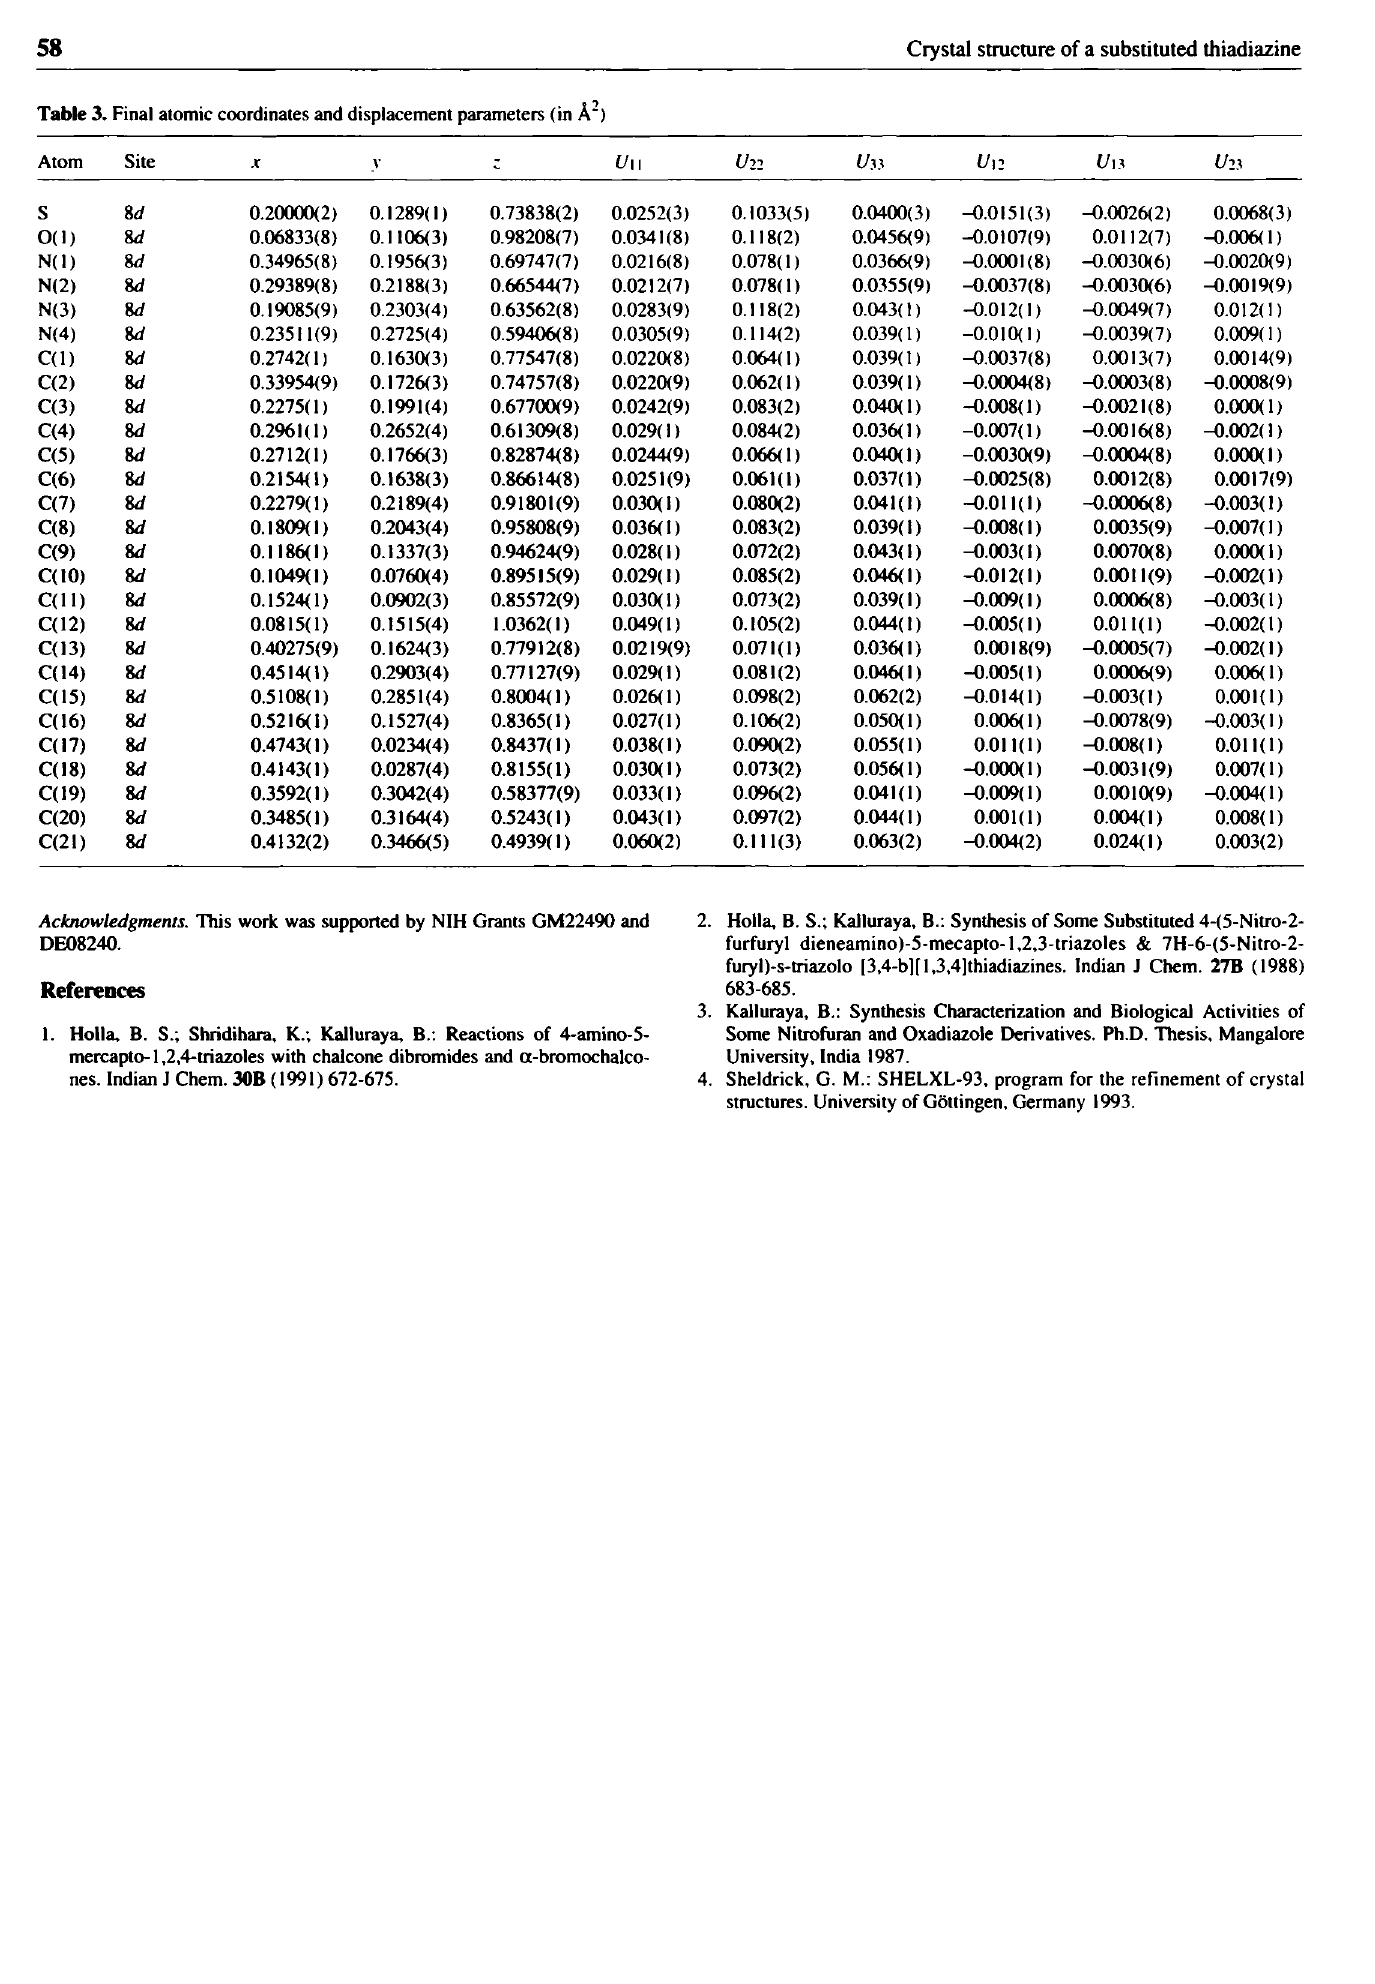
Table 3. Final atomic coordinates and displacement parameters (in Â 2